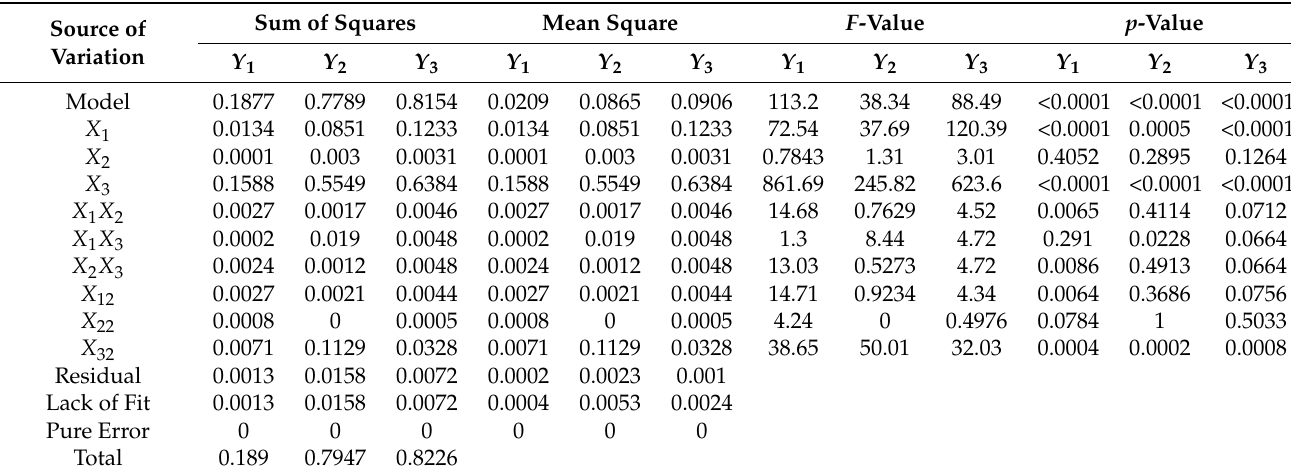
Table 6. Accuracy evaluation of response function